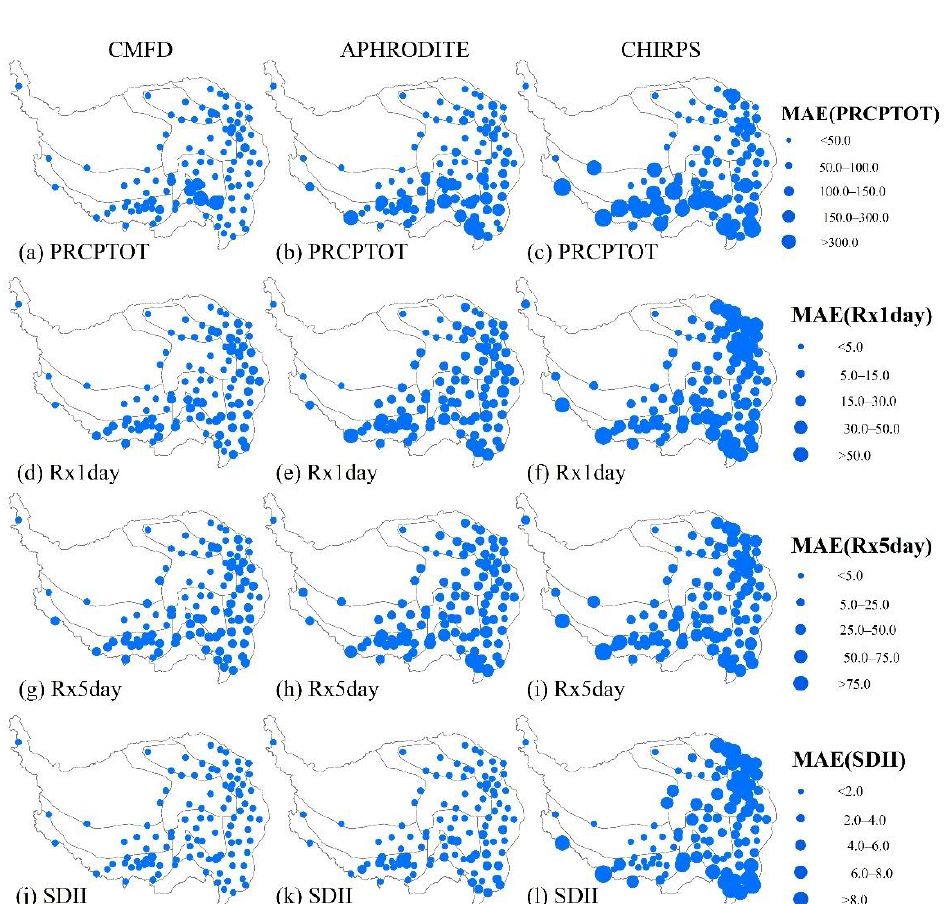
Figure 19. MAE for gauge-based non-threshold indices PRCPTOT, Rx1day, Rx5day, and SDII as derived from CMFD, APHRODITE, and CHIRPS from 1981 to 2014.